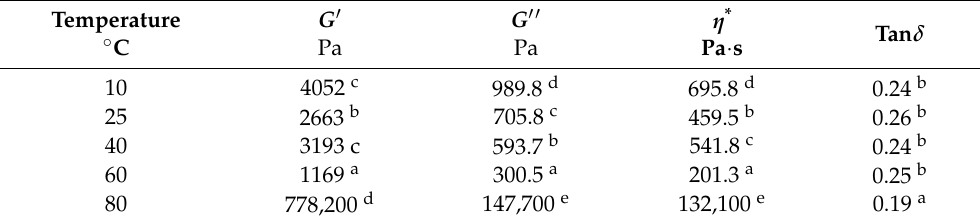
Significant differences in the samples were < 0.01. The different letters within each column are significantly different at p < 0.05.